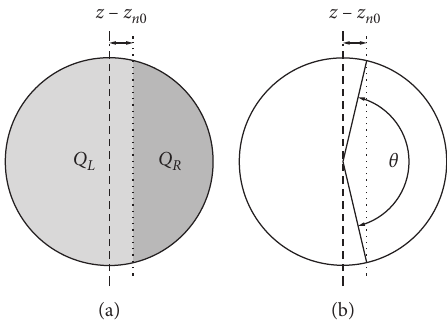
Figure 5: Geometry of water jet separation in